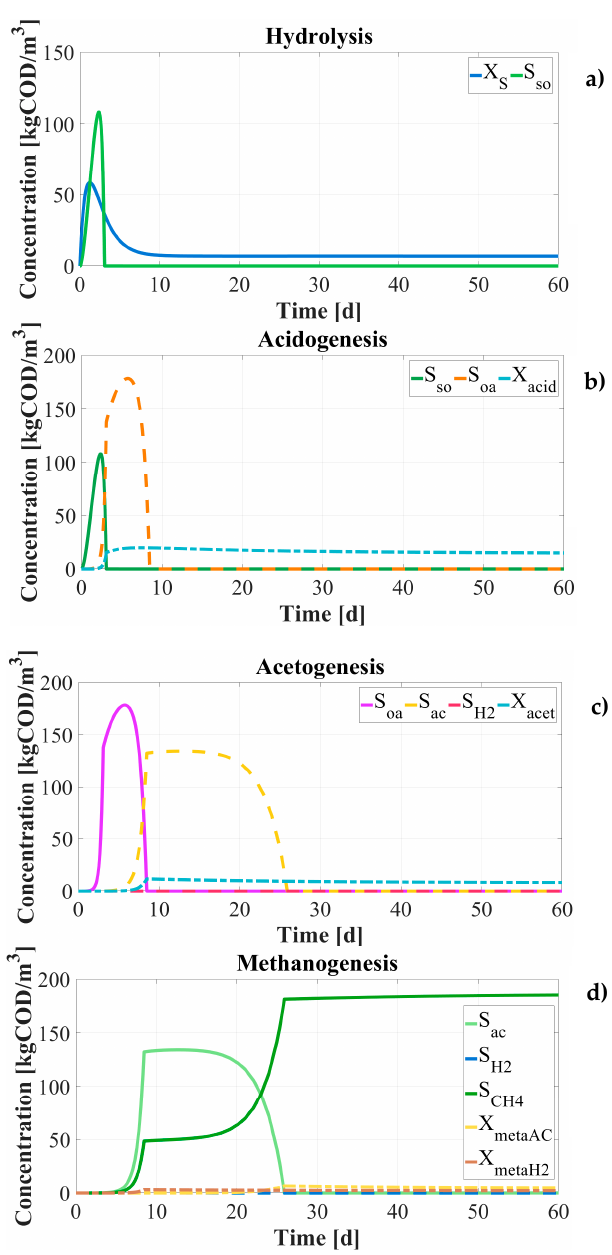
Figure 2. ( a ) Hydrolysis; ( b ) acidogenesis; ( c ) methanogenesis; ( d ) acetogenesis.